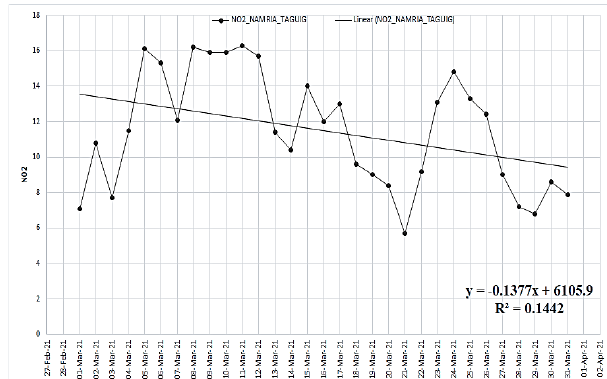
Figure 13. Ground-based observations of NO 2 levels at NAMRIA station on 11/01 to 11/30, 2020.